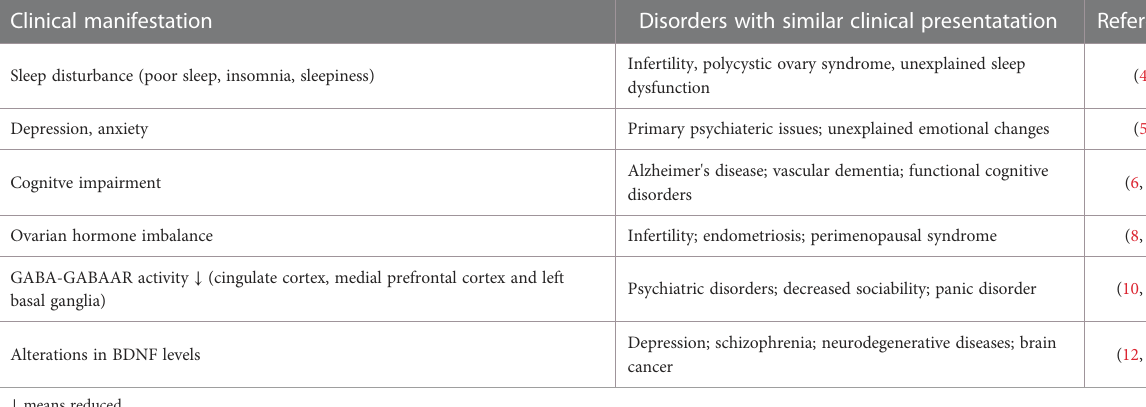
TABLE 1 Clinical manifestations of premenstrual syndrome.